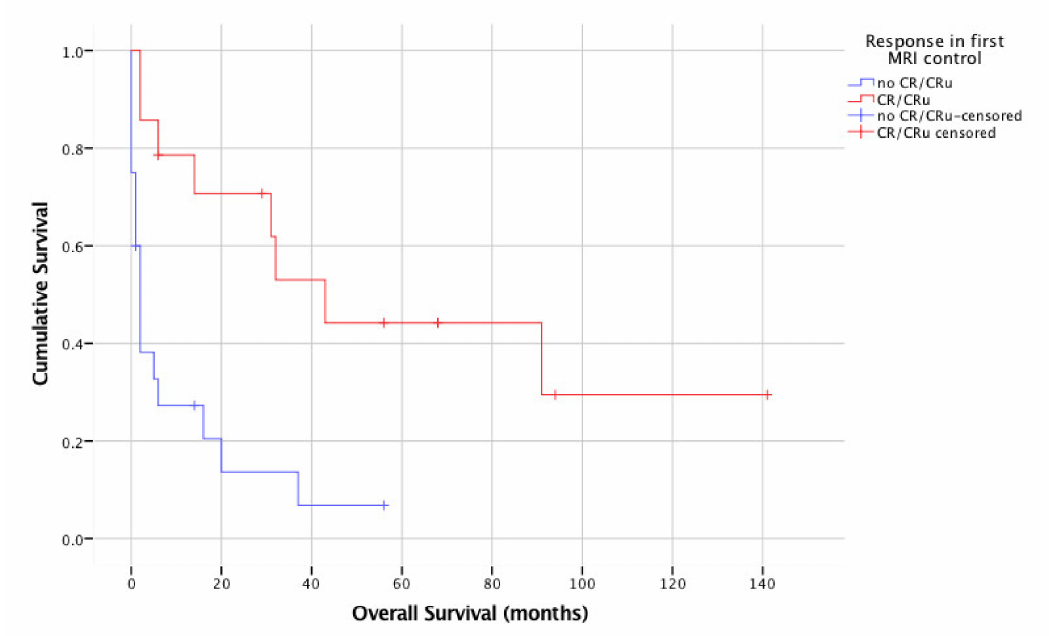
Figure 2. Overall survival according to response in first “early” MRI ( n = 34).